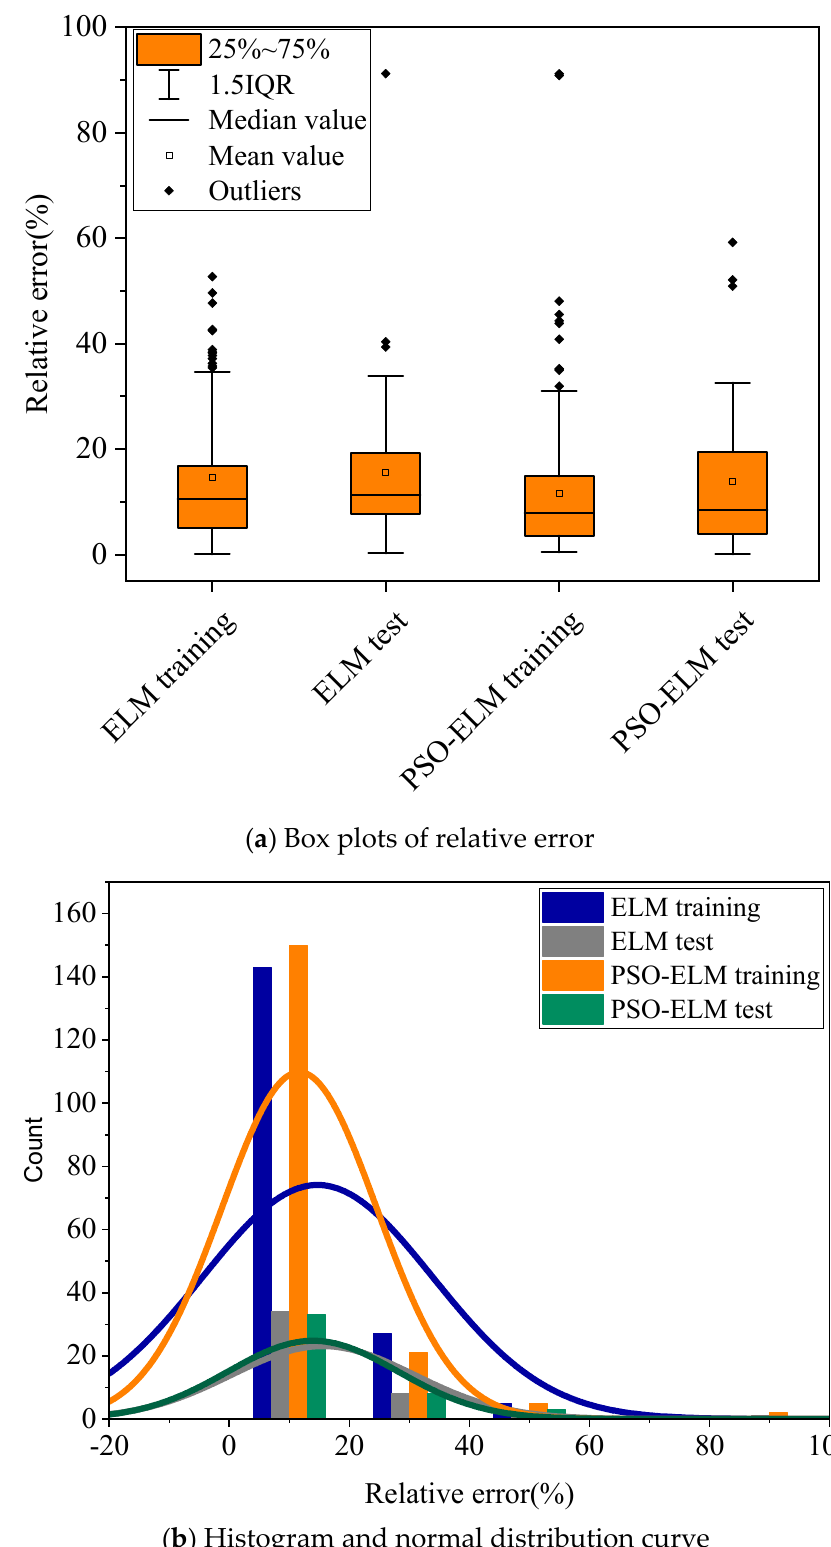
( b ) Histogram and normal distribution curve Figure 7. Relative error distribution. Figure 7. Relative error Table 3. Comparison of evaluation metrics for the prediction results of the two models.